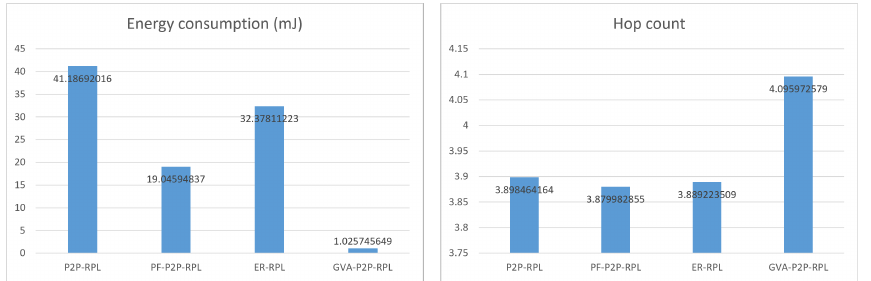
Figure 17. Energy consumption (mJ) and hop